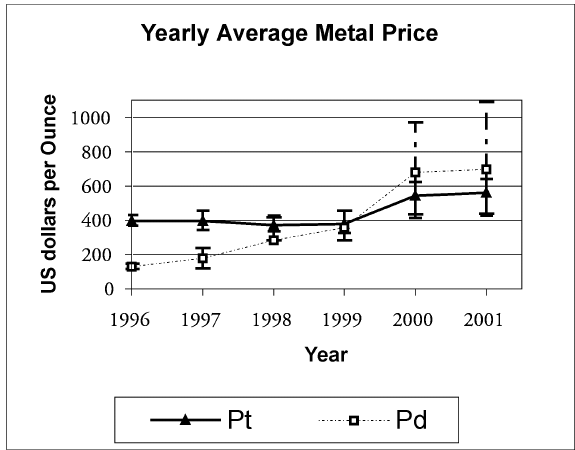
FIGURE 1 Palladium and platinum prices, 1996 to